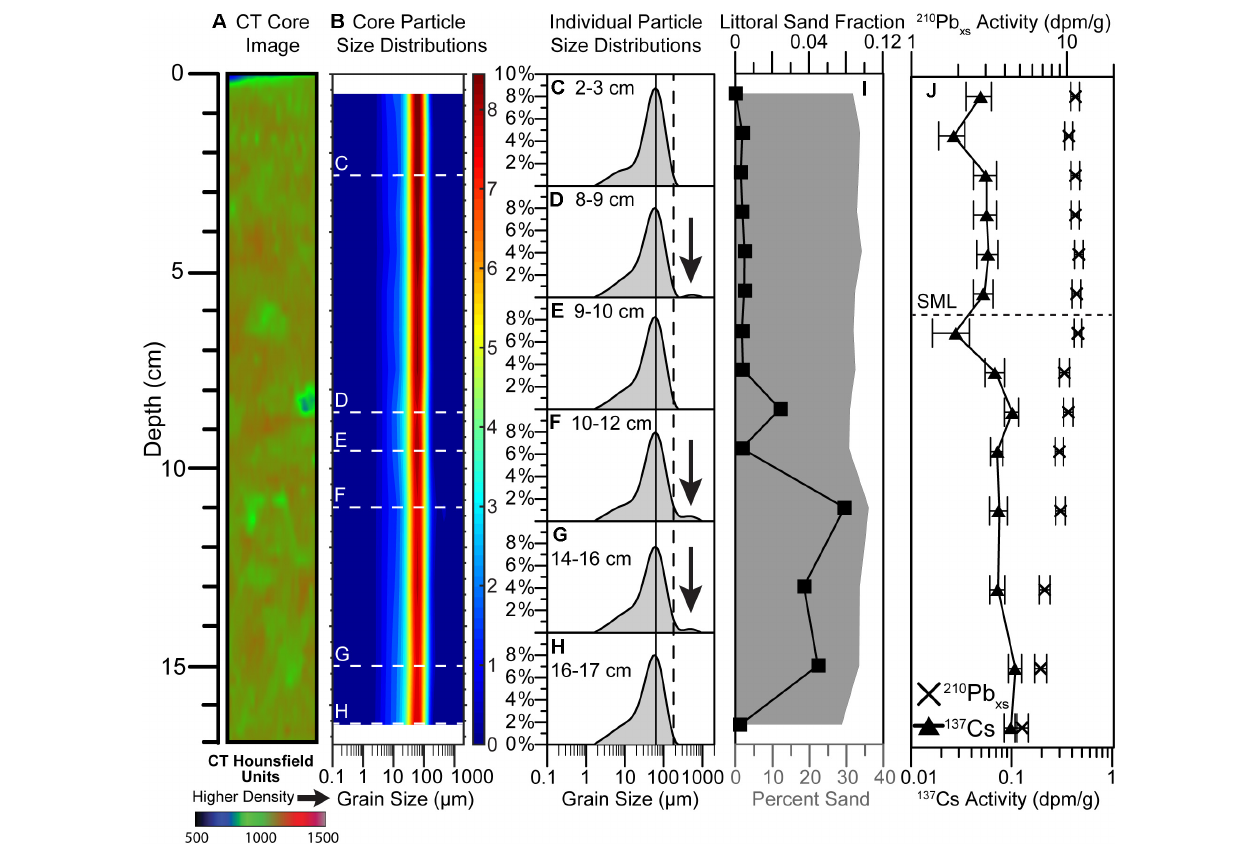
FIGURE 4 | Results from SR1707-07MC (see Figure 1 for location). (A) CT image of the core where cooler colors (blues and greens) are relatively lower density deposits, and warmer colors (reds) are higher density. (B) Down core total grain size distribution for all samples. In this plot the y-axis is depth down the core, x-axis is particle size, and the colors represent the volume present of the sample that fall within those size classifications, where warmer colors are higher percentages and cooler colors are lower percentages. The warmest color region across any depth horizon represents the mode for the sample. Representative individual sample particle size distributions (PSD) are shown in (C–H) , where the depths of these PSD are highlighted in (B) as white dashed lines. The solid black vertical line in (C–H) notes the silt/sand boundary at 63 µ m and the dashed black vertical line notes the Monterey Bay littoral cutoff diameter at 180 µ m (see text for explanation). Black arrows in the plot point to samples with increases in material coarser than the littoral cutoff diameter. The raw measurement size bins for the instrument were used to create the distributions in (B–H) . (I) Down core results from the grain size analysis with total percent sand (gray area) and the littoral sand fraction (black squares – see text for explanation). (J) Down core results for the 210 Pb xs (black Xs) and 137 Cs (black triangles). The dashed horizontal line is the inferred depth of the Surface Mixed Layer (SML) based on the 210 Pb xs results. Both 210 Pb xs and 137 Cs were detected at the base of this